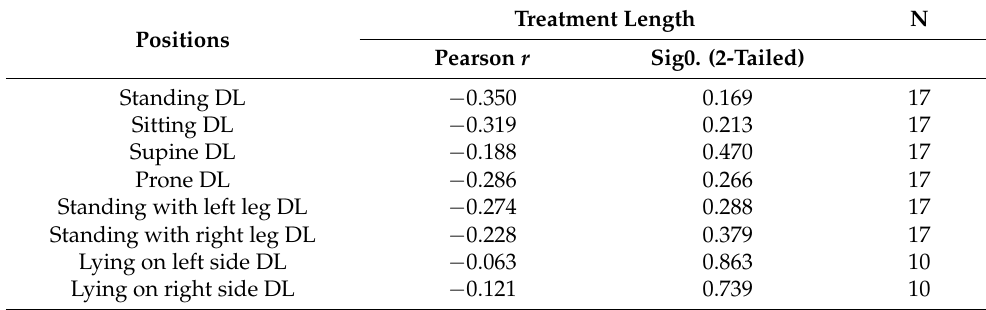
Table 5. Correlation between treatment length and discomfort level for 8 different positions.